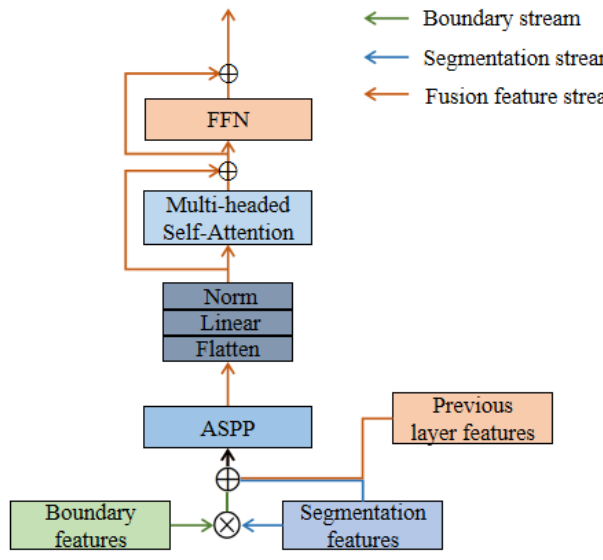
Figure 8. Mixed head